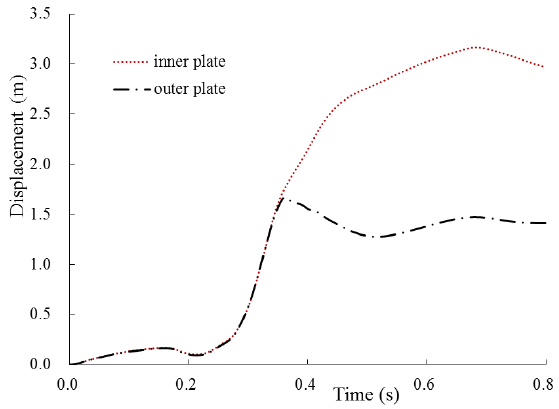
Figure 23. Max displacement time-history of steel plate.